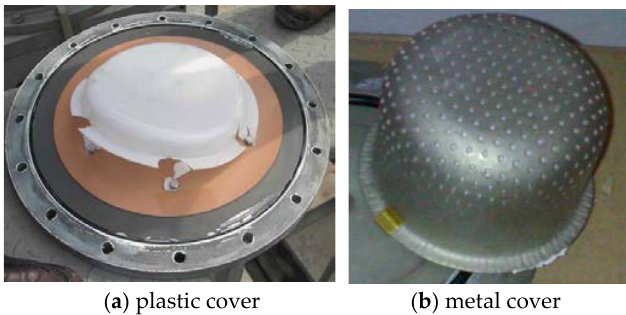
Figure 11. The covers with two different materials.